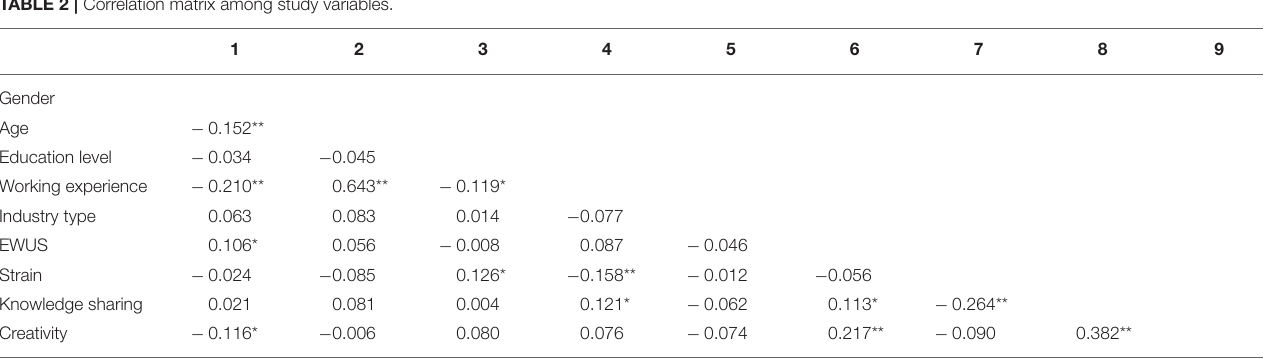
TABLE 2 | Correlation matrix among study